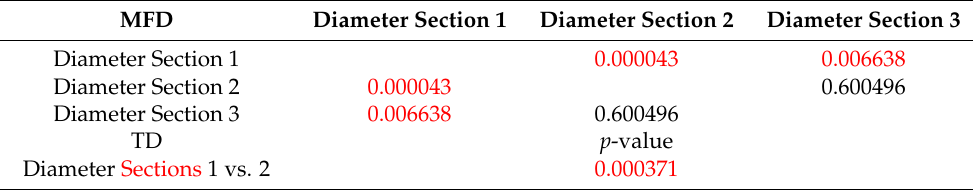
Table 4. Statistical results of the comparison of the debarked stem